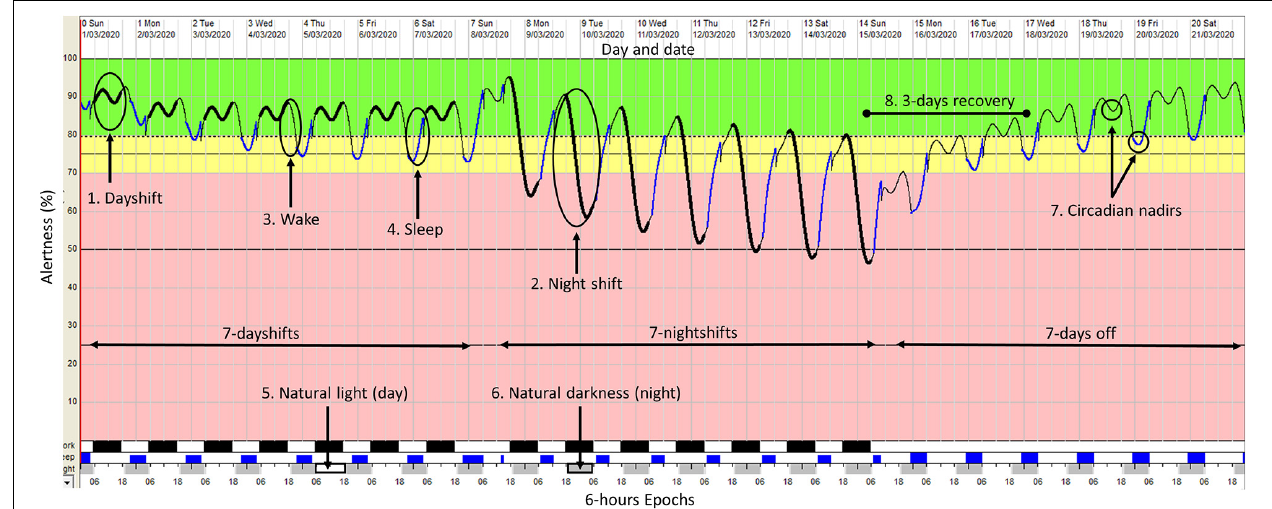
FIGURE 2 | An example of the graphical output from the FASTTM software. This FAST output depicts a 7 days/7 nights/7 days off roster cycle with sleep-wake inputs based on industry research (6.5h sleep when working dayshift; 5.5 h sleep when working night shift; 7 h sleep on days off) (Kecklund and Axelsson, 2016). Alertness is depicted by the oscillating colored line running through the center from left to right. The y-axis displays the alertness value as a percentage (1–100%) by time across the x -axis (6-hour epoch). The thick black line represents periods at work (dayshift or nightshift) (points 1 and 2), the thin black line represents periods of wake with no work and no sleep (point 3) and the blue line represents periods of sleep (point 4). The light gray and white blocks across the x -axis represent periods of natural light (daytime) (point 5) and natural darkness (night time) (point 6). The oscillating alertness line shows two circadian nadirs within every 24-hour (point 7). The first nadir occurs at night time (03:00–06:00) and the second during daytime (13:00–15:00). In this example, working a roster cycle that includes 7-day shifts followed by seven-night shifts, can take a shift worker 3 days to recover to optimal alertness levels ( > 80%) (point